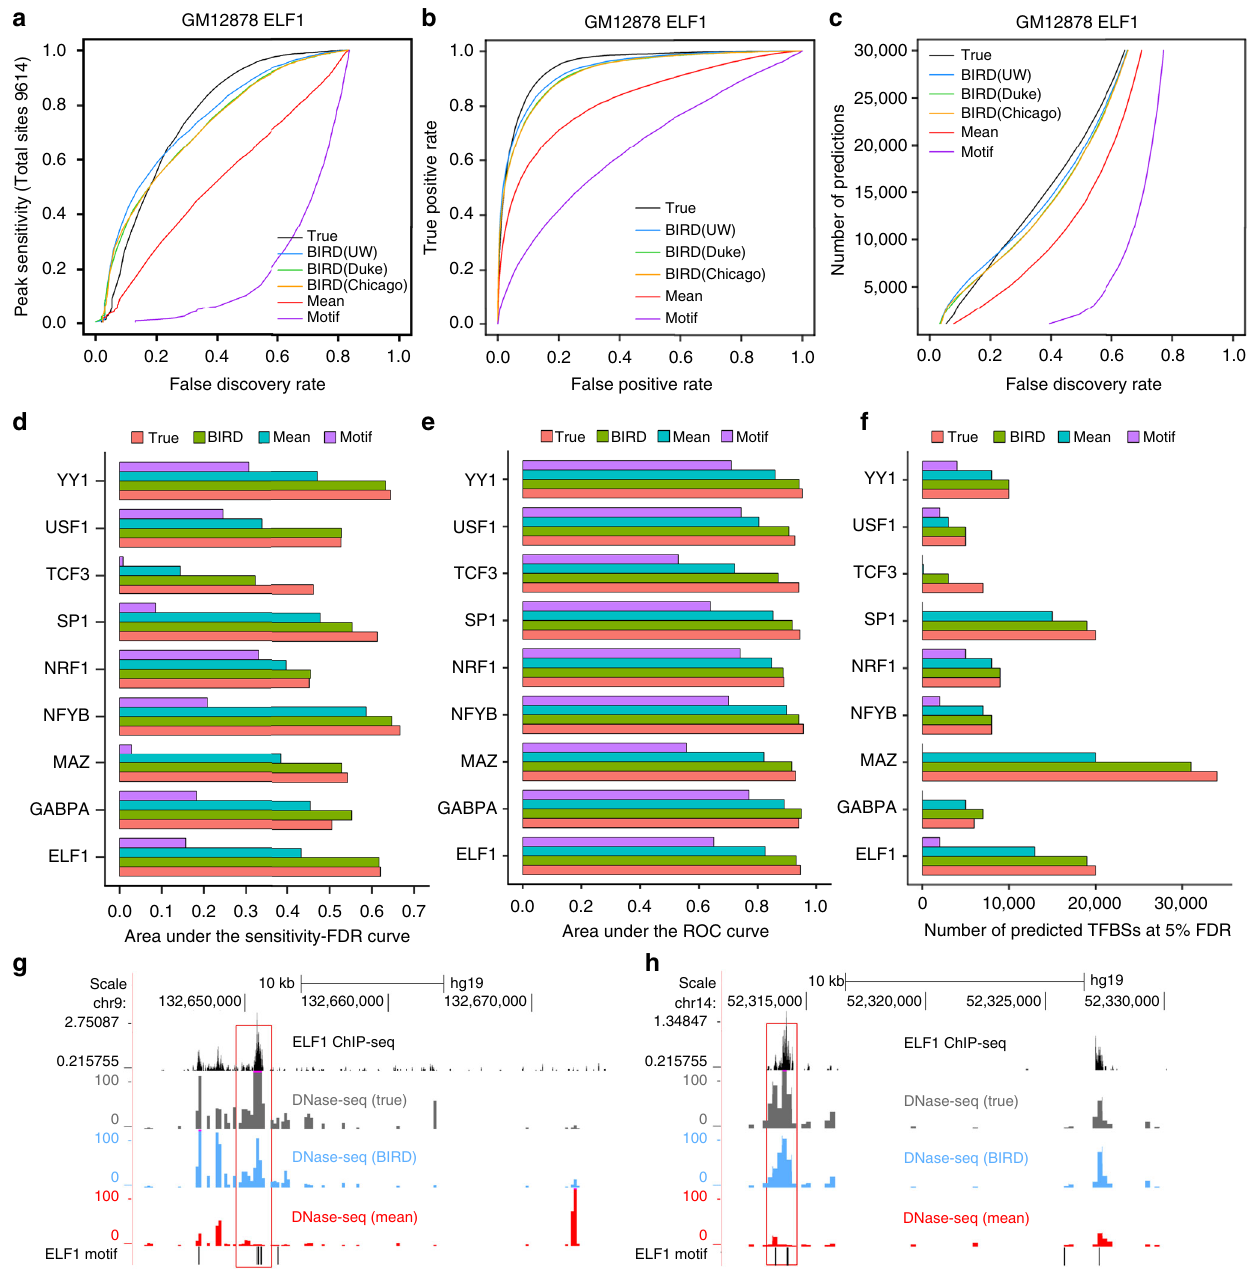
Fig. 4 Predicting transcription factor binding sites. a Sensitivity – FDR curve for predicting ELF1 binding sites in GM12878 using four different methods: true DNase-seq data ( “ True ” ), BIRD, mean DH pro fi le of training cell types ( “ Mean ” ), and motif mapping score ( “ Motif ” ). For BIRD, “ BIRD(UW) ” , ” BIRD(Duke) ” , and “ BIRD(Chicago) ” denote predictions made using exon arrays generated by three different labs. For each method, the sensitivity – FDR curve shows the percentage of gold standard TFBSs that were discovered by the predicted binding sites at different FDR levels. The total number of gold standard TFBSs was shown on the y axis in the brackets. b ROC curve for predicting ELF1 binding sites in GM12878 using different methods. c The number of DHSs predicted to be ELF1 binding sites in GM12878 by different methods at different FDR levels. d Area under the sensitivity – FDR curve for predicting TFBSs of nine TFs in GM12878 using “ True ” , “ BIRD ” (based on BIRD(UW)), “ Mean ” , and “ Motif ” . e Area under the ROC curve for predicting TFBSs of nine TFs in GM12878 using different methods. f Number of predicted TFBSs at 50% FDR for predicting TFBSs of nine TFs in GM12878 using different methods. g , h Two examples showing the true ELF1 ChIP-seq signal (read count, black) in GM12878, the true DNase-seq signal (gray), the BIRD-predicted DH signal (blue), and the “ Mean ” DH signal in training cell types (red). Locations of ELF1 motif sites are shown on the bottom. BIRD more accurately captured the true signal than “ Mean ” (highlighted with red boxes). It also predicts TFBSs better than the motif only approach as many motif sites are not bound and do not have DH signal at